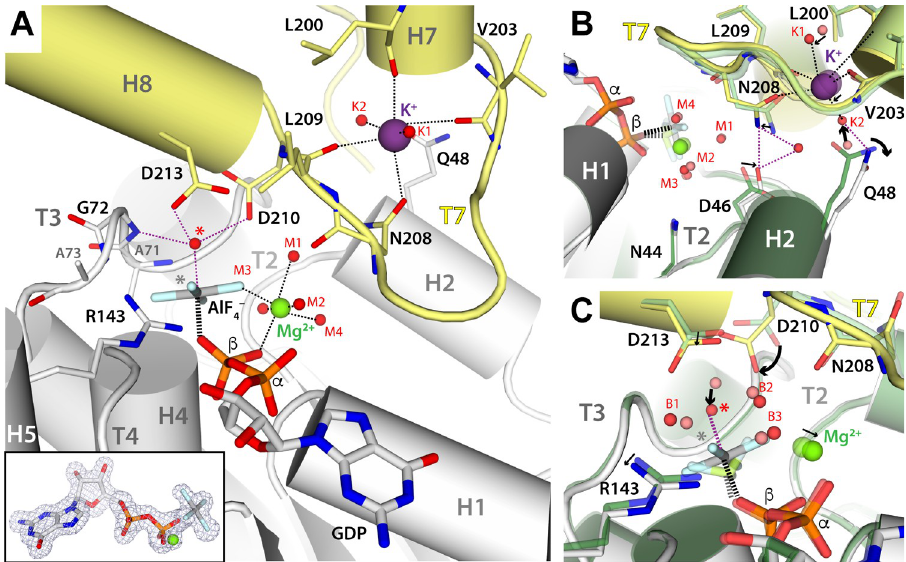
Fig 4. Nucleotide-binding pocket in the SaFtsZ structure complexed with GDP, AlF 4 − , and Mg 2+ . (A) Overall view of the interface between adjacent subunits. Structural elements and relevant residues are labeled, while Mg 2+ , K + , and water are represented as green, purple, and red spheres, respectively. Red and gray stars indicate, respectively, the catalytic water and the fourth F atom position in AlF 4 − as compared to BeF 3 − . Coordination contacts and H-bonds are shown as black and purple dash lines, respectively. Inset: Polder OMIT map around the nucleotide mimetic and Mg 2+ ion. (B, C) Superposition of the SaFtsZ structure in complex with GDP, AlF 4 − , and Mg 2+ (gray and yellow for bottom and top monomers, red spheres for water) onto that in complex with GDP, BeF 3 − , and Mg 2+ (dark green and light green for bottom and top monomers, salmon spheres for water). Black arrows indicate conformational rearrangements between both